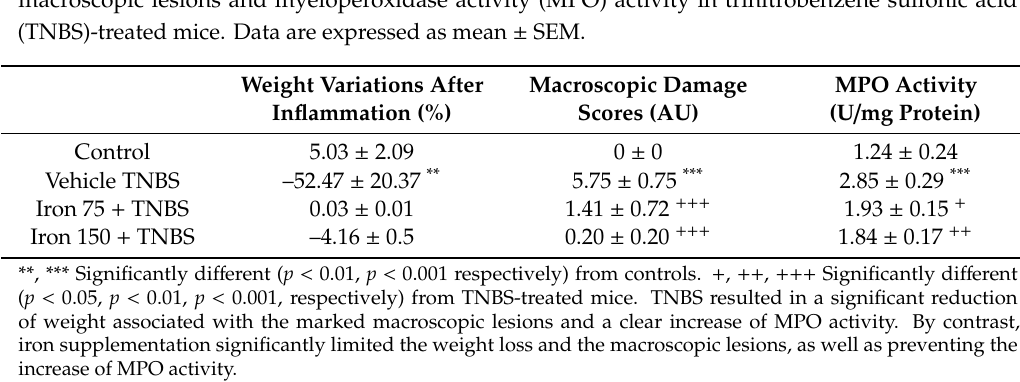
Table 2. The incidence of iron supplementation (75 and 150 mg / kg / day po ) on weight variations, macroscopic lesions and myeloperoxidase activity (MPO) activity in trinitrobenzene sulfonic acid (TNBS)-treated mice. Data are expressed as mean ±